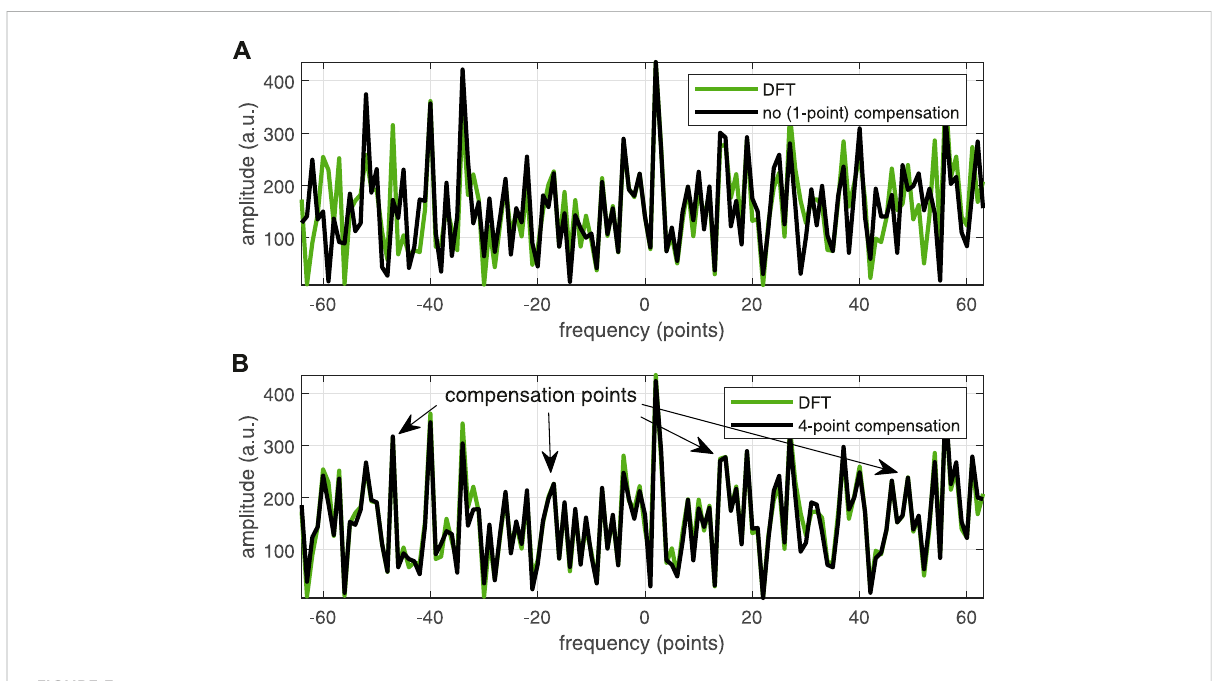
FIGURE 3 Power spectrum of an random sequence given by Eq. 7 (green curves) and Eq. 9 (black curves) with N = 64, M = 128. (A) No compensation, default